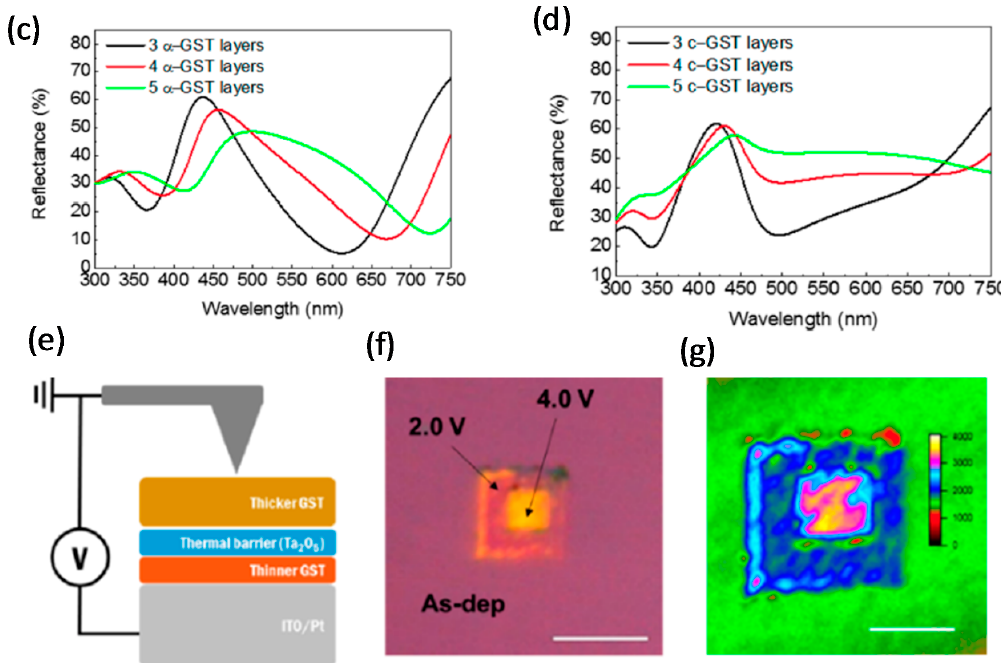
Figure 9. GST-based multicolor changeable optical coating. ( a ) A depicted working mechanism of two GST layers separated by an oxide under amorphous and crystalline phases; ( b ) Three different groups of GST/oxide/GST samples under the crystalline, semicrystalline, and amorphous phases. The simulated reflectance of multilayer coatings under ( c ) amorphous and ( d ) crystalline phases; ( e ) Sketch of CAFM for the electrical response of the device. Three distinct color phases of the samples obtained using ( f ) an optical microscope and ( g ) a confocal laser scanning microscope (CLSM). Adapted from [73], with permission from © 2016 American Chemical Society.